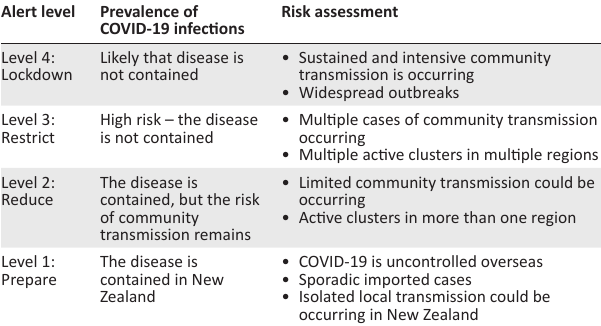
TABLE 1: Summary of New Zealand’s coronavirus disease 2019 alert levels. Alert level Prevalence of Risk assessment COVID-19 infections Level 4: Lockdown